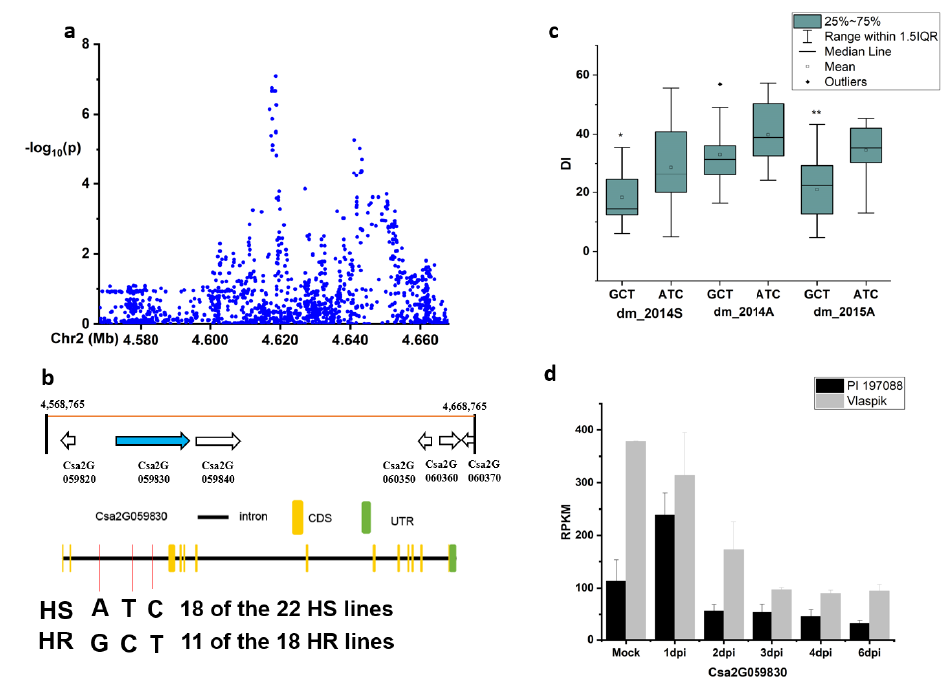
Figure 5. Identification of the causal gene for the locus dmG2. 1. ( a ) Local Manhattan plot surrounding the peak of dmG2. 1; ( b ) six genes were predicted in the 50-kb region around the peak dmG2.1 and SNP variation of the candidate gene Csa2G059830 between the highly susceptible (HS) and highly resistant (HR) lines (see Supplementary File 5); ( c ) disease index (DI) comparison between haplotypes of the HS and HR lines (see Supplementary File 3); ( d ) RPKM (Reads Per Kilobase Million) of candidate gene Csa2G059830 based on the transcriptome of PRJNA285071 (data obtained from http://cucurbitgenomics.org/rnaseq/cu/19)[24]. * and ** indicate significance at p < 0.05 and p < 0.01, respectively.